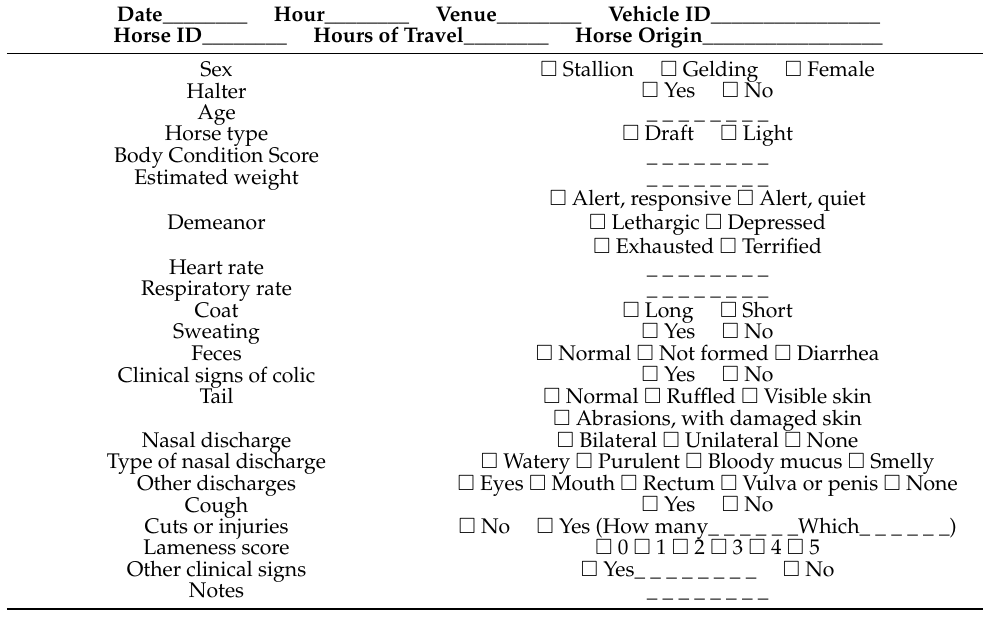
Table 2. Checklist used within 30 min after unloading of the last animal to evaluate the welfare status of the individual horses at the lairage facilities in a Southern Italy slaughterhouse (modified from Messori et al.